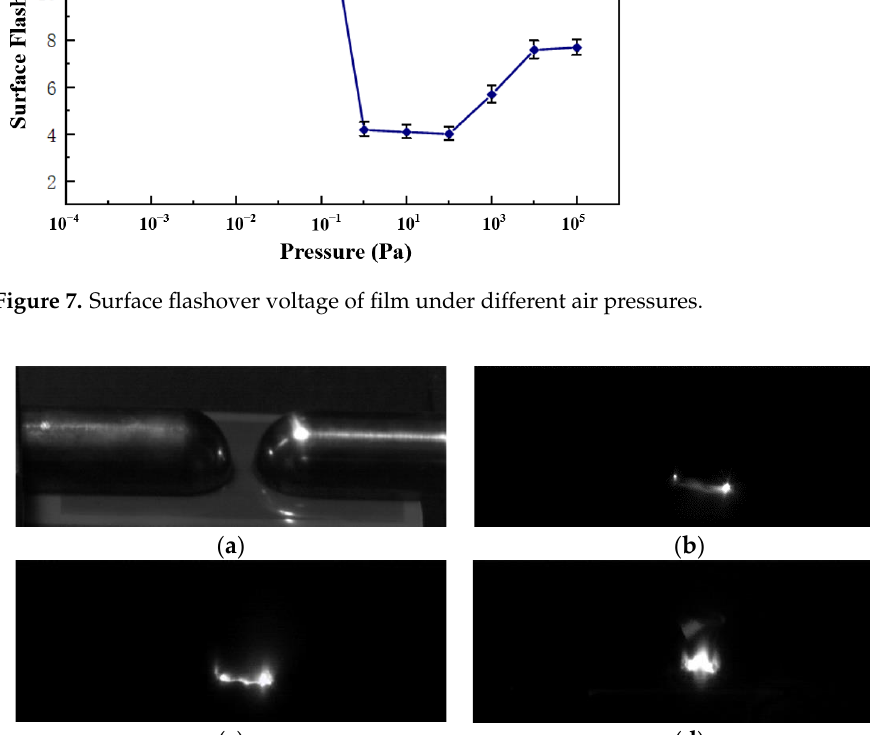
Figure 8. The flashover phenomenon along the surface of the film. ( a ) surface flashover platform; ( b ) flashover initiation; ( c ) form flashover channel; ( d ) surface flashover.